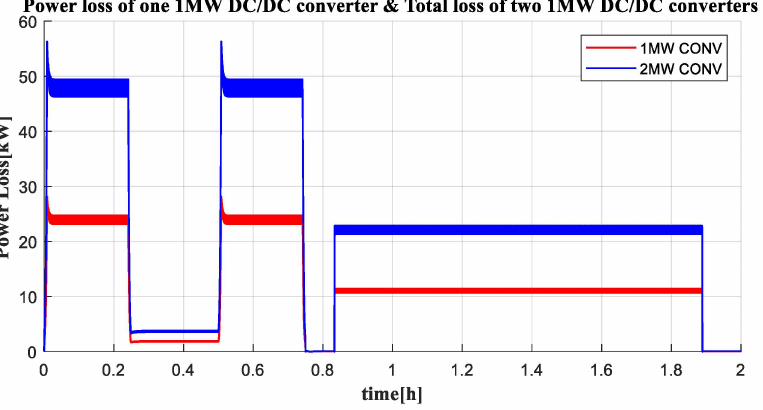
Figure 27. Simulation results for the power loss of 1 MW DC/DC converters #1, #2.